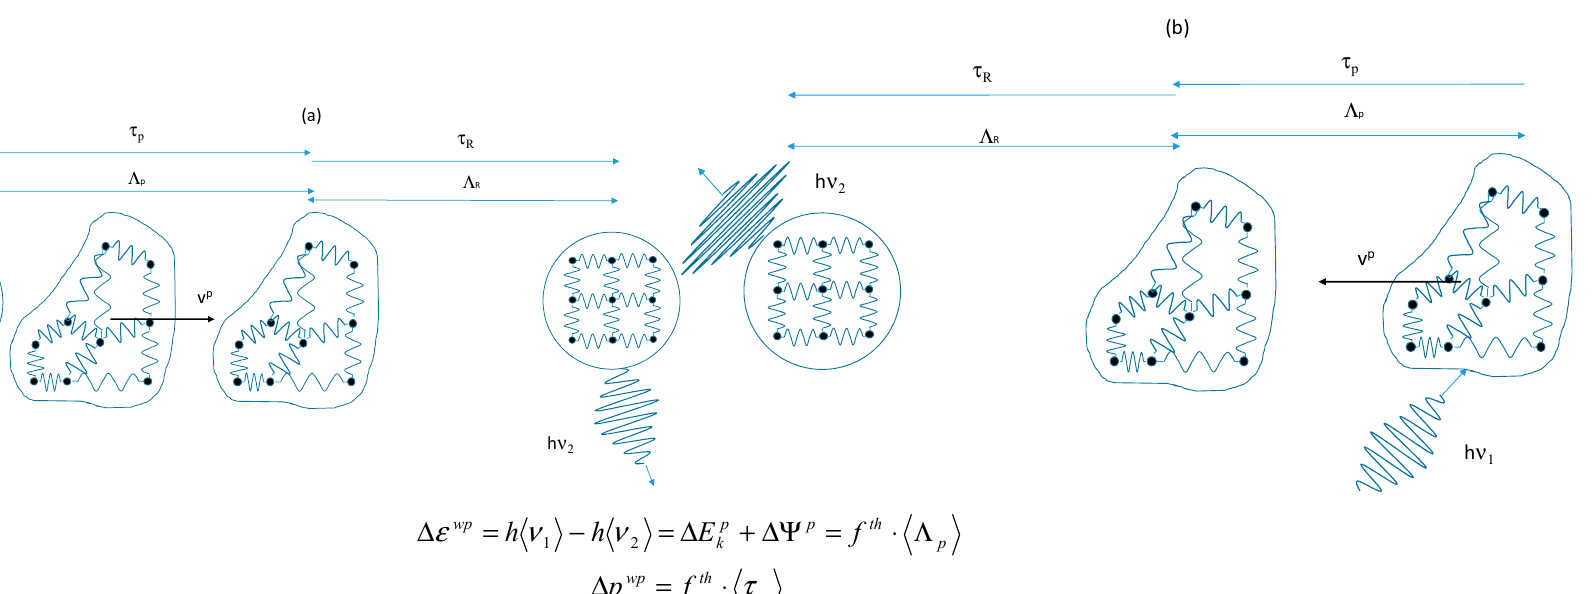
Figure 1. Schematic representation of inelastic collisions between wave packets and liquid particles. The event represented in ( a ), in which an energetic wave packet transfers energy and momentum to a liquid particle, is commuted upon time reversal into the one represented in ( b ), where a liquid particle transfers energy and momentum to a wave packet. The particle changes velocity and the frequency of wave packet is shifted by the amount ( ν 2 − ν 1 ). Due to its time symmetry, this mechanism has been assumed the equivalent of Onsager’ reciprocity law at microscopic level [10,11,17]. In a pure isothermal liquid, energy and momentum exchanged among the icebergs are statistically equivalent, and no net effects are produced. Events of type ( a ) will alternate with events of type ( b ) so that the balance of the two energy pools is unaltered. In addition, the macroscopic equilibrium will also ensure the mesoscopic equilibrium; events ( a ) and ( b ) will be equally probable along any direction to have a zero average over time and space. On the contrary, if a symmetry breaking is introduced, as, for instance, a temperature or a concentration gradient, one type of event will prevail over the other along a preferential direction (Re-drawn after Peluso, F., [18]).